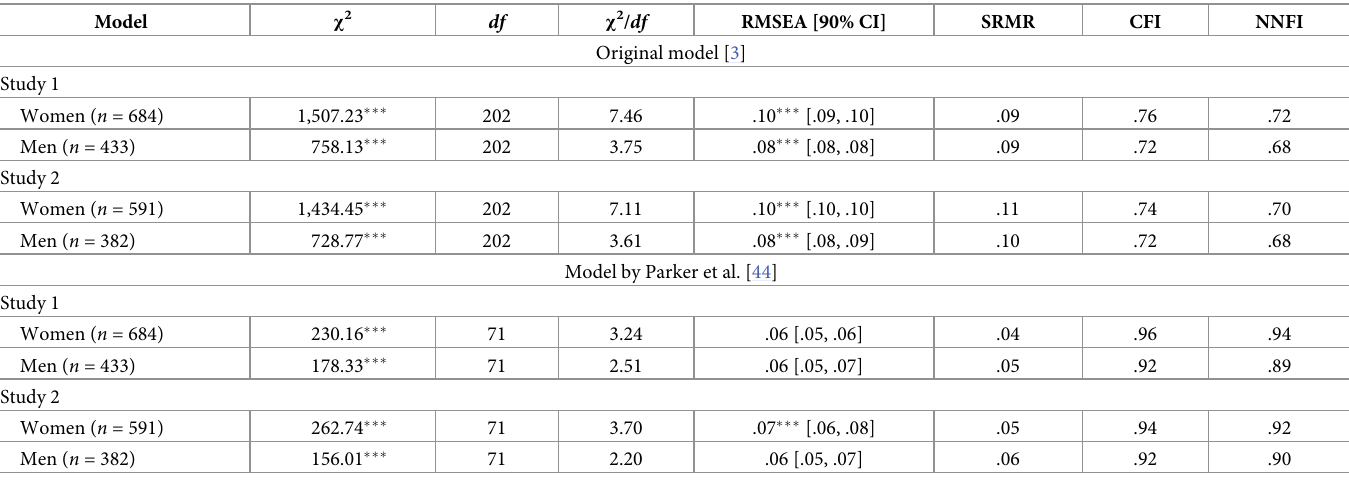
Table 2. Results of the confirmatory factor analysis of two measurement models of the eating disorder examination questionnaire in women and men. Model